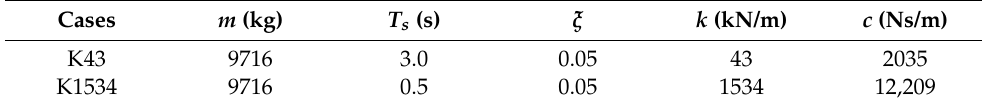
Table 3. The parameters of the mass–spring–damper system of Xu and Cai [36].